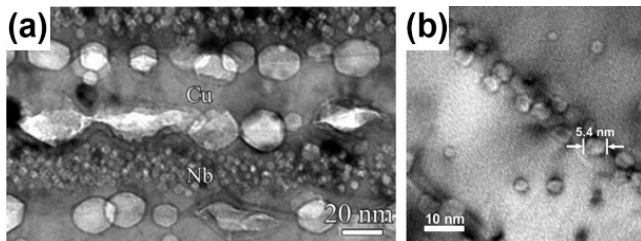
Figure 22. ( a ) Cavities in irradiated Cu/Nb multilayers with 58 nm layer thickness [22]. ( b ) Cavities in irradiated nanocrystalline W [60].